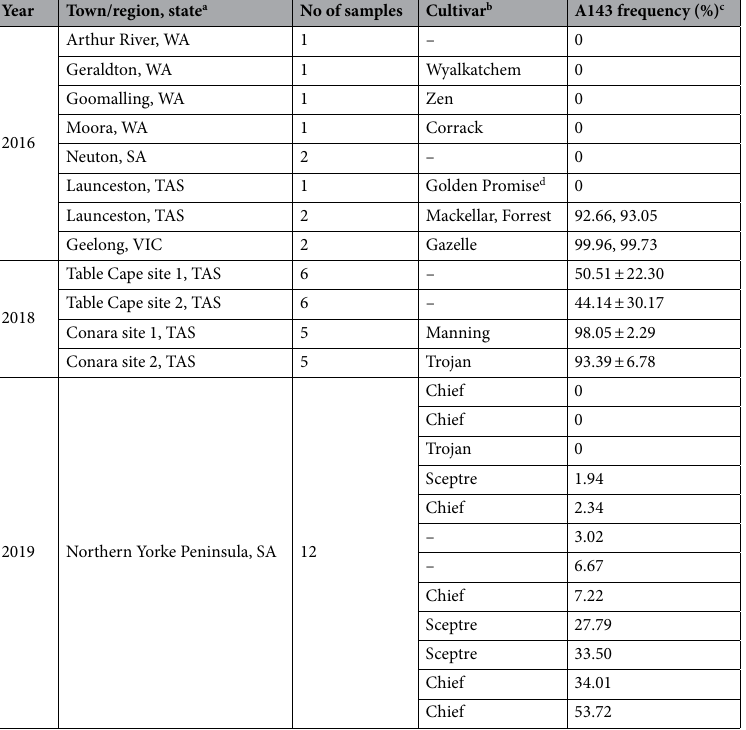
Primer name a Sequence (5 ′ –3 ′